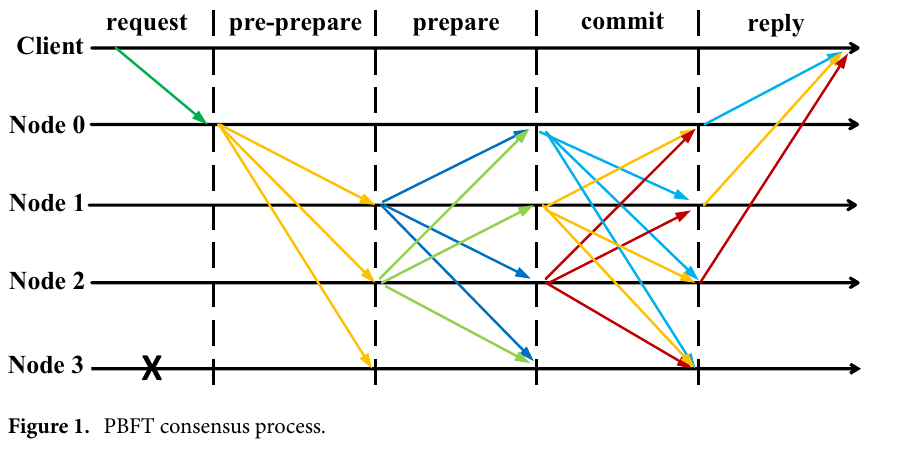
Figure 1. PBFT consensus